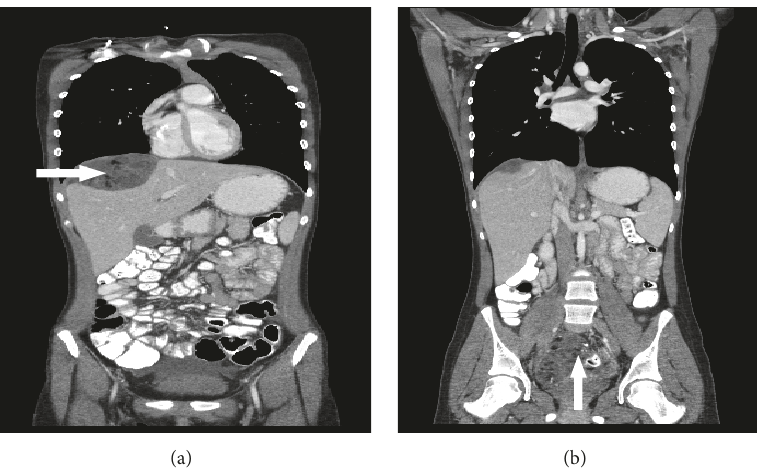
Figure 3: Computed tomography abdomen and pelvis follow-up imaging at 8 months. (a) Large mass occupying the right upper abdominal cavity, revealing multiple new masses containing cystic and necrotic elements surrounding the liver (arrow). Because of tumor growth, the giant mass had compressed the liver parenchyma. (b) Pelvic tumor is demonstrated as well (arrow).